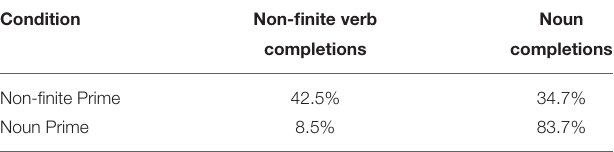
TABLE 1 | Percentage completions of intransitive non-finite verbs and nouns in conditions (a) and (b) for Experiment 1. We only consider intransitive non-finite verb as correct completions.